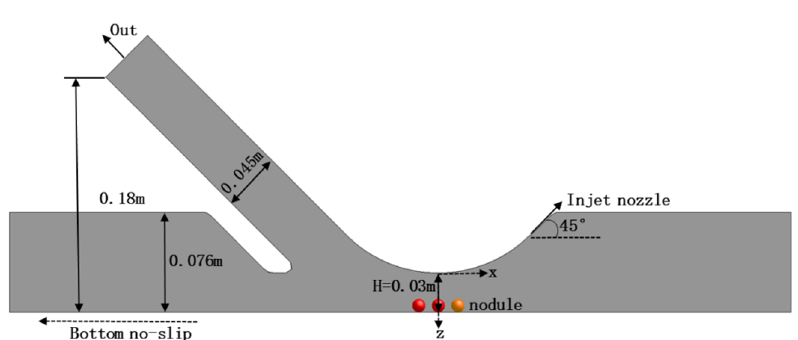
Figure 5. Coand ă effect-based hydraulic collector Figure 5. Coandă effect-based hydraulic collector model. Figure 5. Coandă effect-based hydraulic collector model.